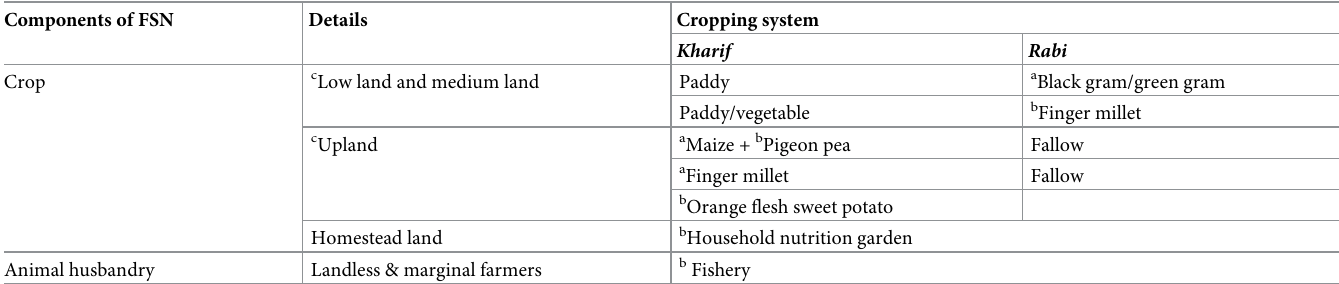
Table 1. Details of FSN interventions in